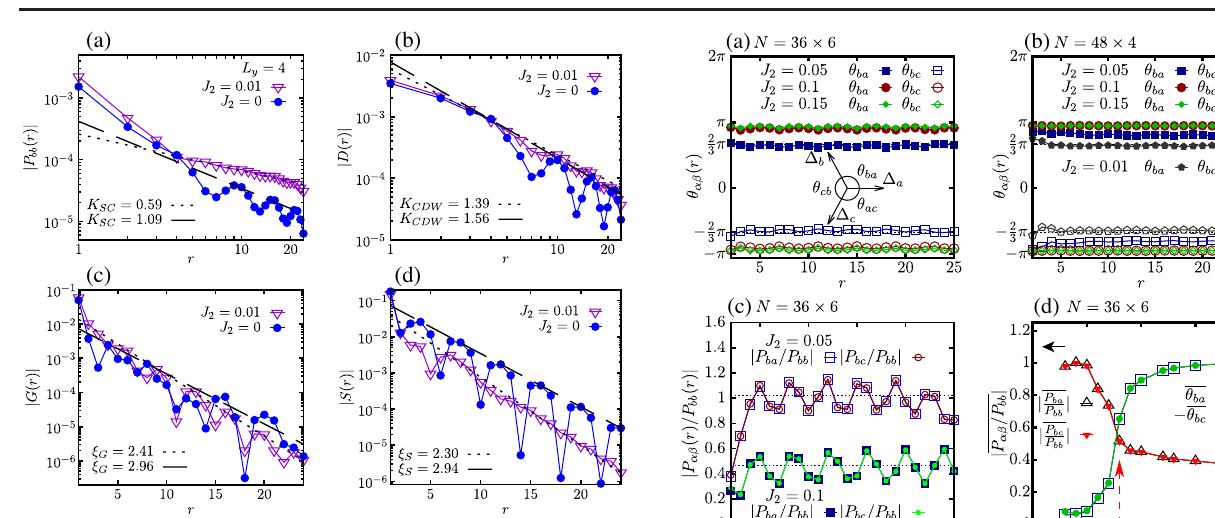
FIG. 4. Pairing and other correlations at J χ ¼ 0 . 05 for smaller J L 4 . The results are converged with a large bond 2 on y ¼ dimension M ¼ 10 000 . (a) The SC pairing correlations. r is chosen along the x direction r ¼ ð r; 0 Þ , and the reference point is r L = 4 ; L = 2 Þ to avoid the boundary effect. The straight-line 0 ¼ ð x y fit in the log-log plot follows a power-law behavior, with exponents of 1.09 and 0.59 for J 2 ¼ 0 and 0.01, respectively. (b) The density-density correlations j D ð r Þj which are fit by a power-law relation, with exponents of 1.56 and 1.39 for J 2 ¼ 0 and 0.01, respectively. (c) The single-particle correlations j G ð r Þj which are fit by an exponential decay with correlation lengths of 2.96 and 2.41 for J 2 ¼ 0 and 0.01, respectively. (d) The spin correlations j S ð r Þj which are fit by an exponential decay with correlation lengths of 2.94 and 2.30 for J 2 ¼ 0 and 0.01, respectively. The doping level is δ ¼ 1 = 12 . The obtained fitting exponents or correlation lengths have error bars around